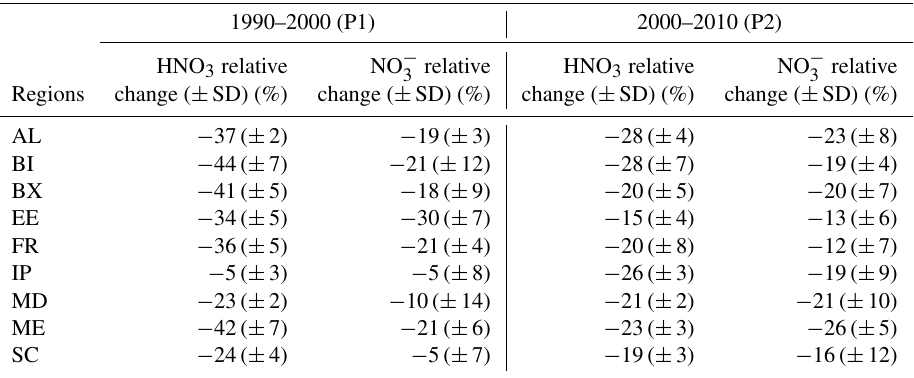
Table 5. Means and standard deviations of the modeled relative changes in HNO 3 and NO − (2000–2010) periods for all the PRUDENCE regions (Fig.